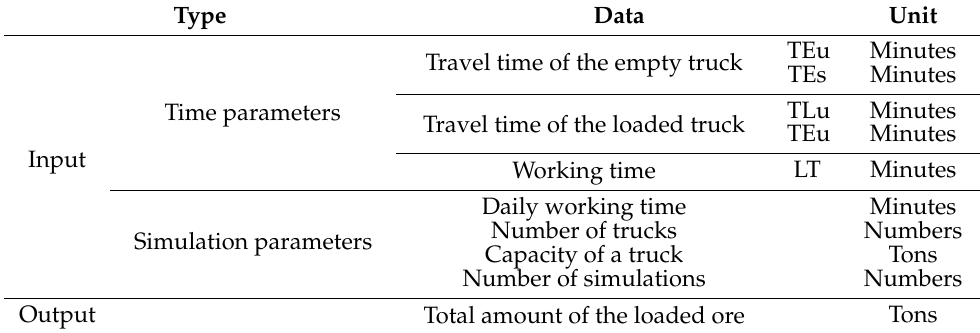
Table 2. Description of the input and output parameters of the truck haulage system simulation.